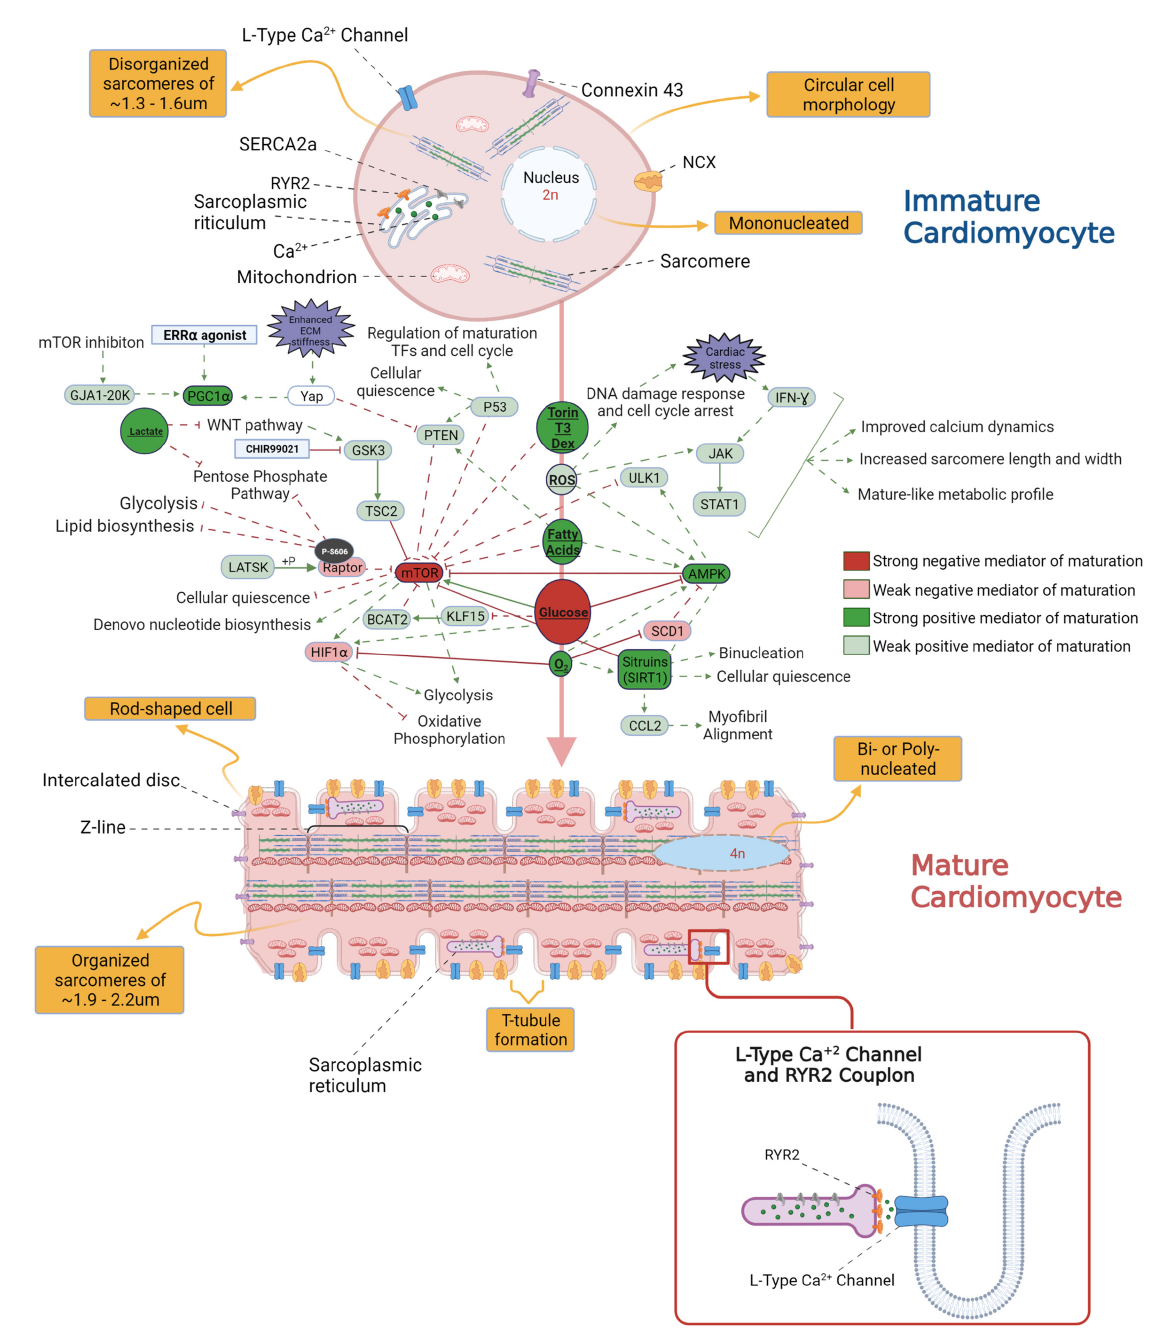
FIGURE1 An overview of the morphological differences between immature and mature cardiomyocytes (CM) and the signaling pathways potentially involved in the transition from fetal to adult CM